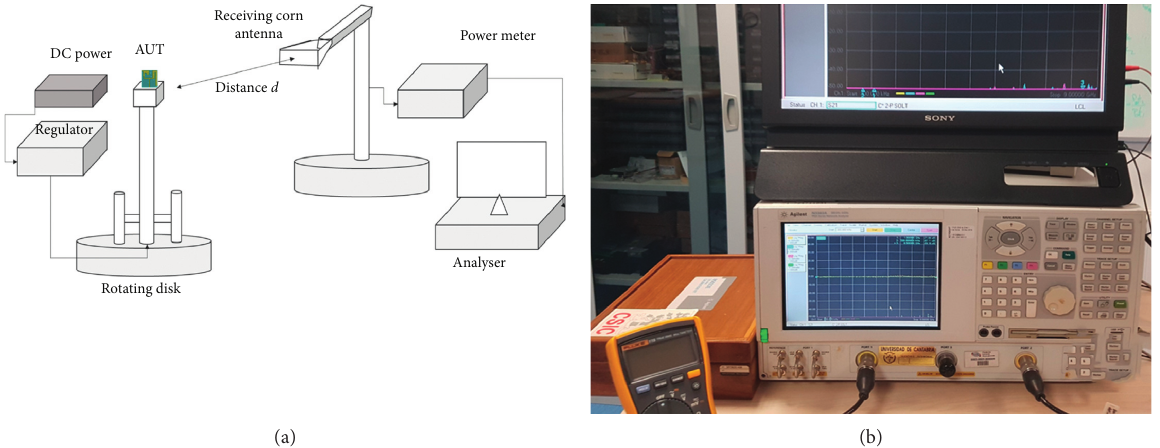
Figure 6: Measurement configuration: (a) gain and radiation pattern [5] and (b) reflection